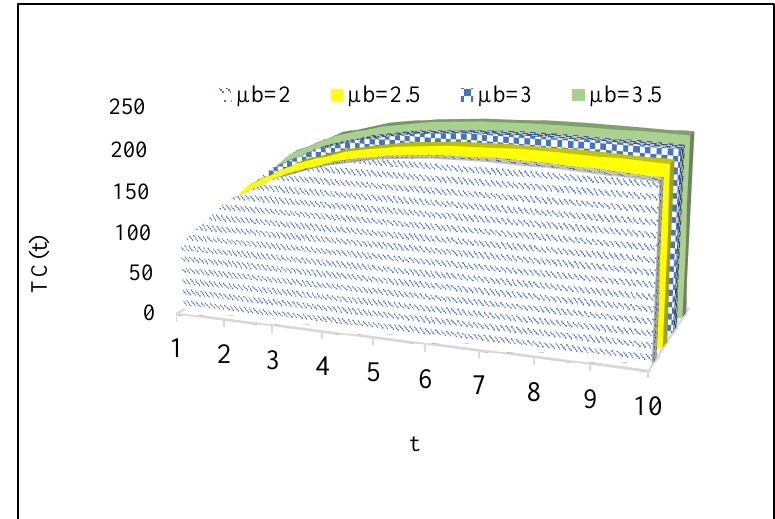
Figure 6. TC(t) vs t at various values of